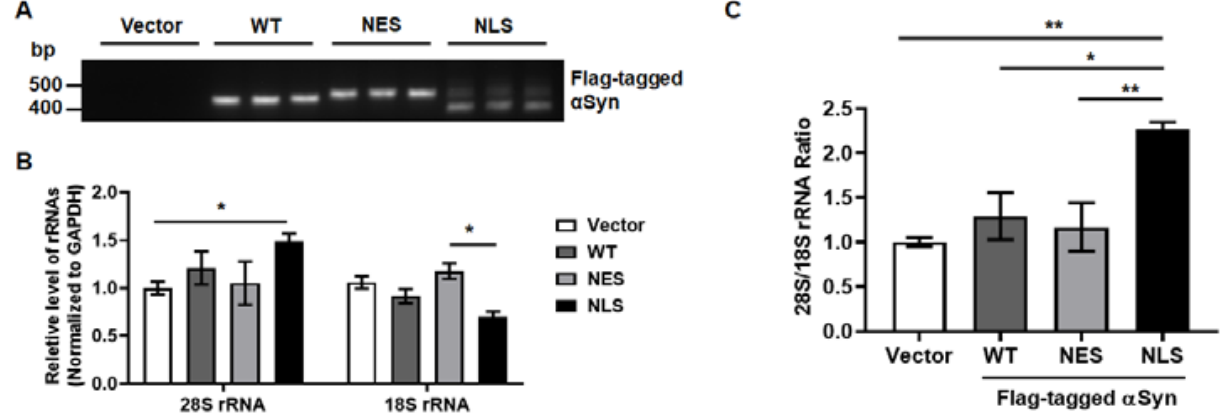
Figure 3. The levels of 28S and 18S rRNA are changed upon the nuclear localization of α Syn. ( A ) The validation of transfected DNA plasmid was confirmed with DNA gel electrophoresis. ( B ) 28S and 18S rRNA were analyzed with qPCR. The nuclear localization of α Syn promoted the induction of 28S rRNA and reduction in 18S rRNA in MEF. ( C ) The 28S/18S rRNA ratios were significantly increased by the nuclear localization of α Syn. We used one-way ANOVA with Tukey’s post hoc test. Data are represented as the mean ± SEM. N = 6; * p > 0.05 and ** p > 0.01.